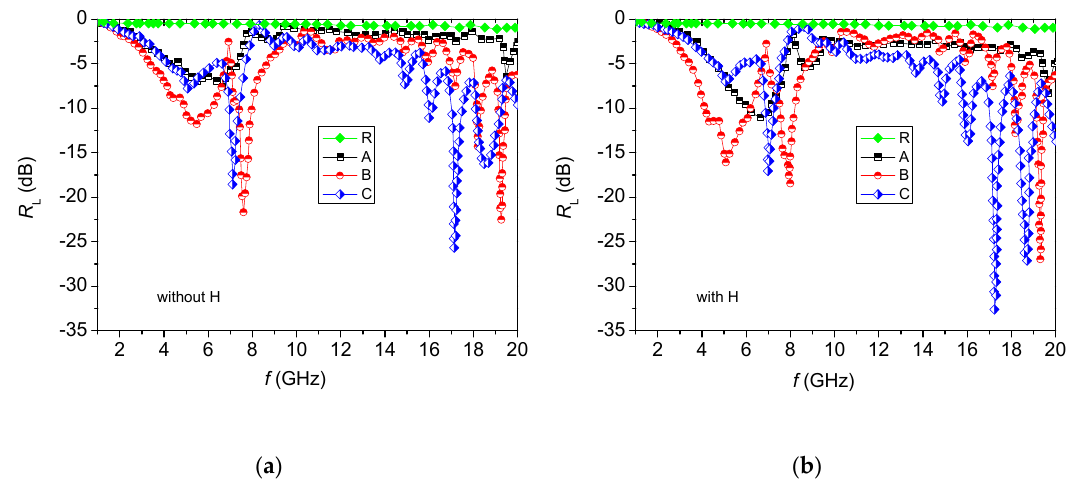
Figure 10. Reflection losses of samples with different filler ratio: ( a ) without magnetic field, ( b ) with an external magnetic field applied.